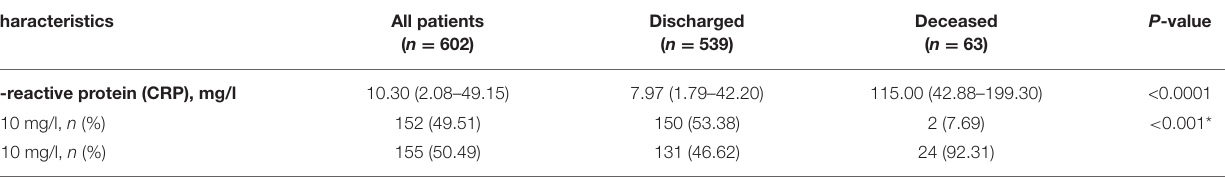
(FIB; Figure 2I ), INR ( Figure 2J ), and D-dimer ( Figure 2K